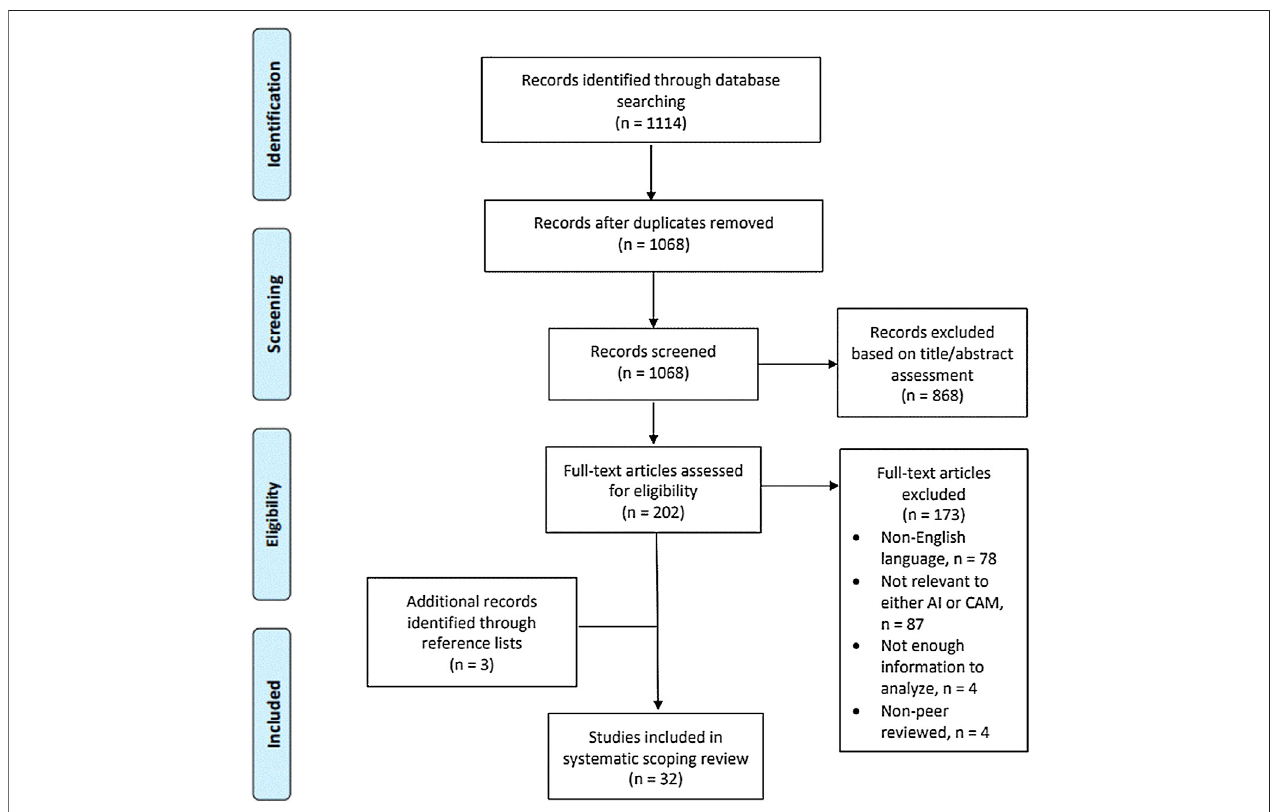
FIGURE 1 | The PRISMA fl ow diagram for the scoping review